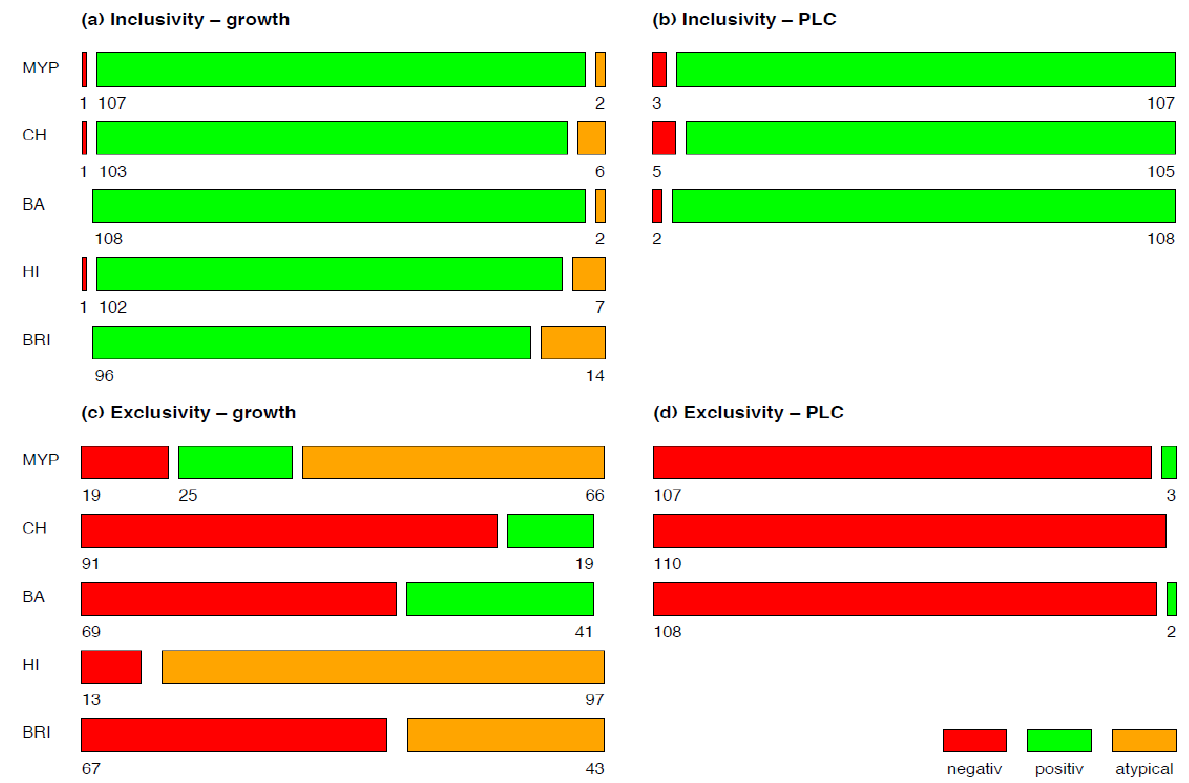
Figure 1. Growth ( a , c ) and phospholipase C reaction ( b , d ) of inclusivity ( n = 110) and exclusivity ( n = 110) test strains. Negative is no-growth, positive is typical growth and atypical is not presumptive